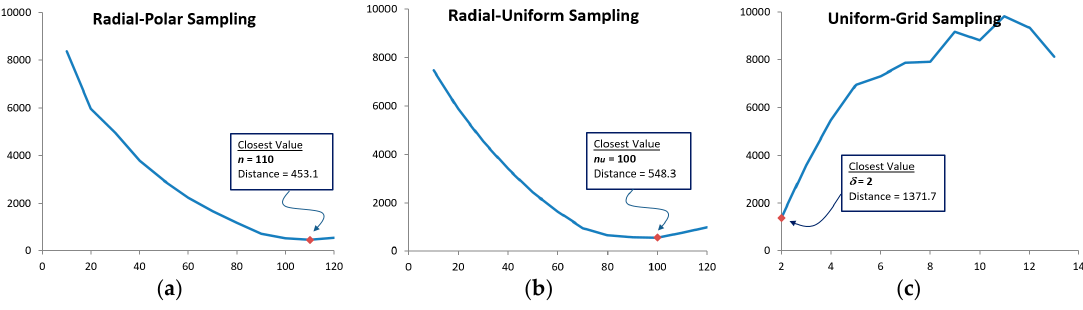
Figure 17. Plots showing the closest matching positions of the LBP feature vector with reference vector for images generated using ( a ) radial–polar sampling; ( b ) radial-uniform sampling; ( c ) uniform-grid sampling.